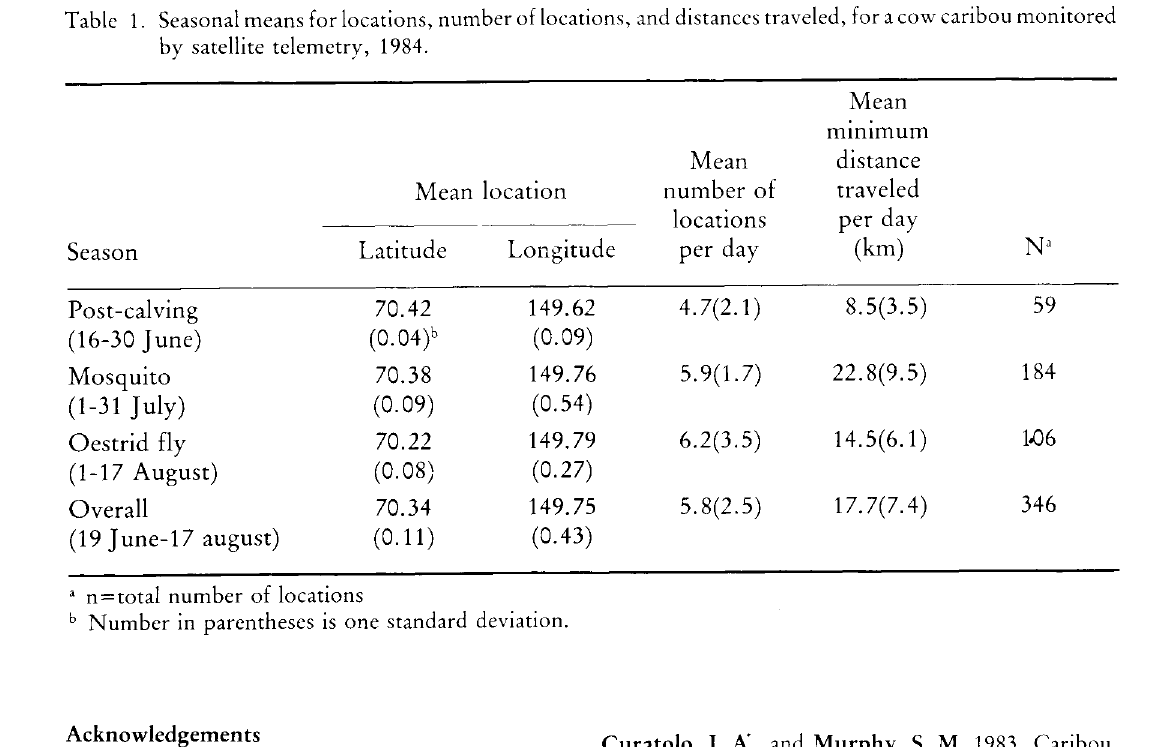
Table 1. Seasonal means for locations, number of locations, and distances traveled, for a cow caribou monitored by satellite telemetry,